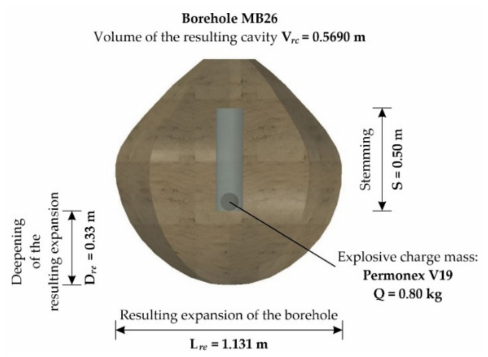
Figure 3. Formed spherical cavity expansion